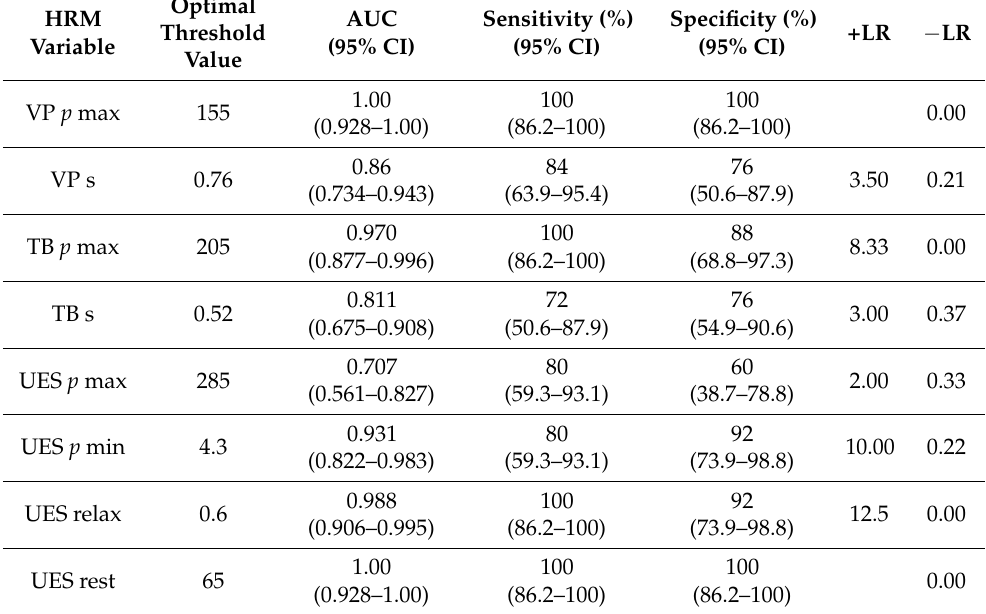
Table 3. Threshold values for each HRM parameter with sensitivity, specificity and predictive values for identifying inhalation risk.